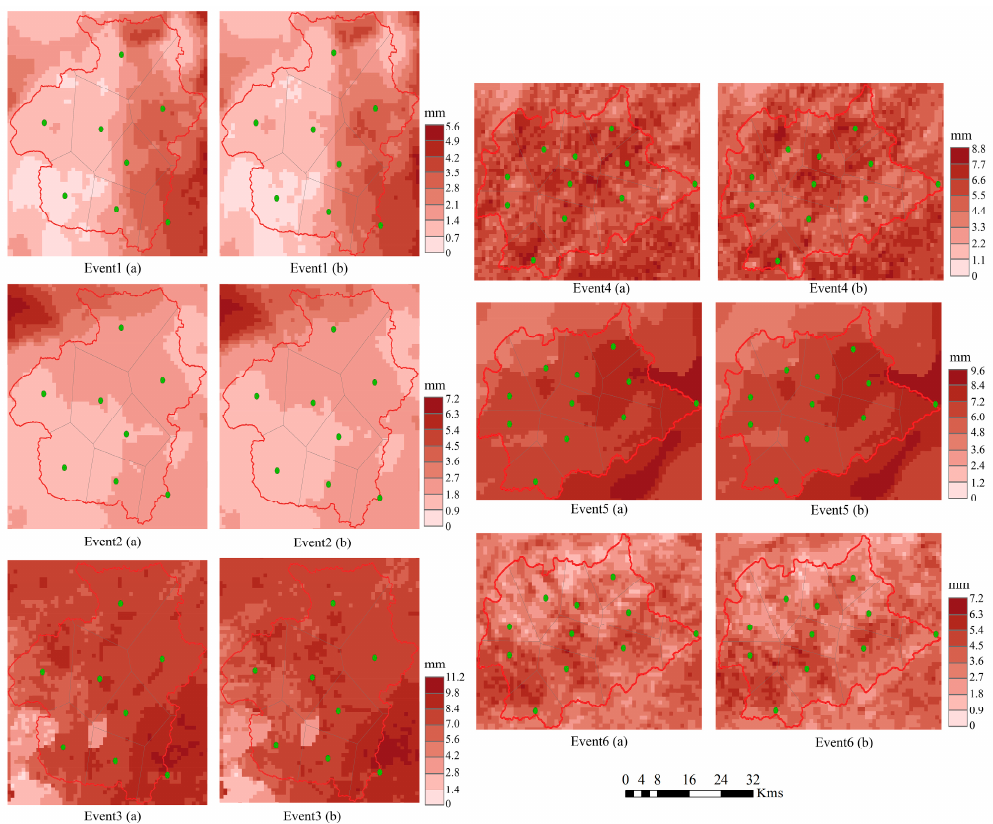
Figure 14. Spatial distributions of the 24 h cumulative evapotranspiration: ( a ) WRF-only; ( b ) the fully coupled WRF/WRF-Hydro.